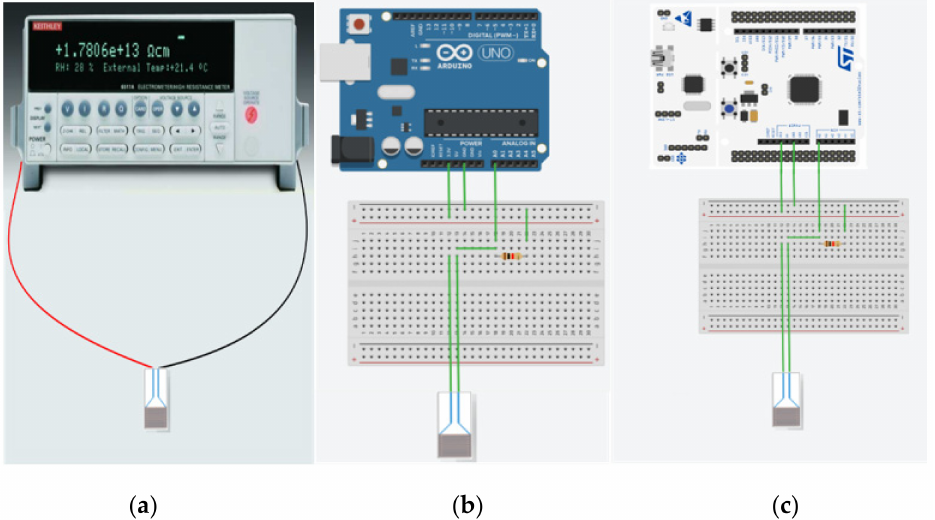
Figure 2. Schematic representation of the ( a ) Lab setup; ( b ) Arduino setup; ( c ) STM32